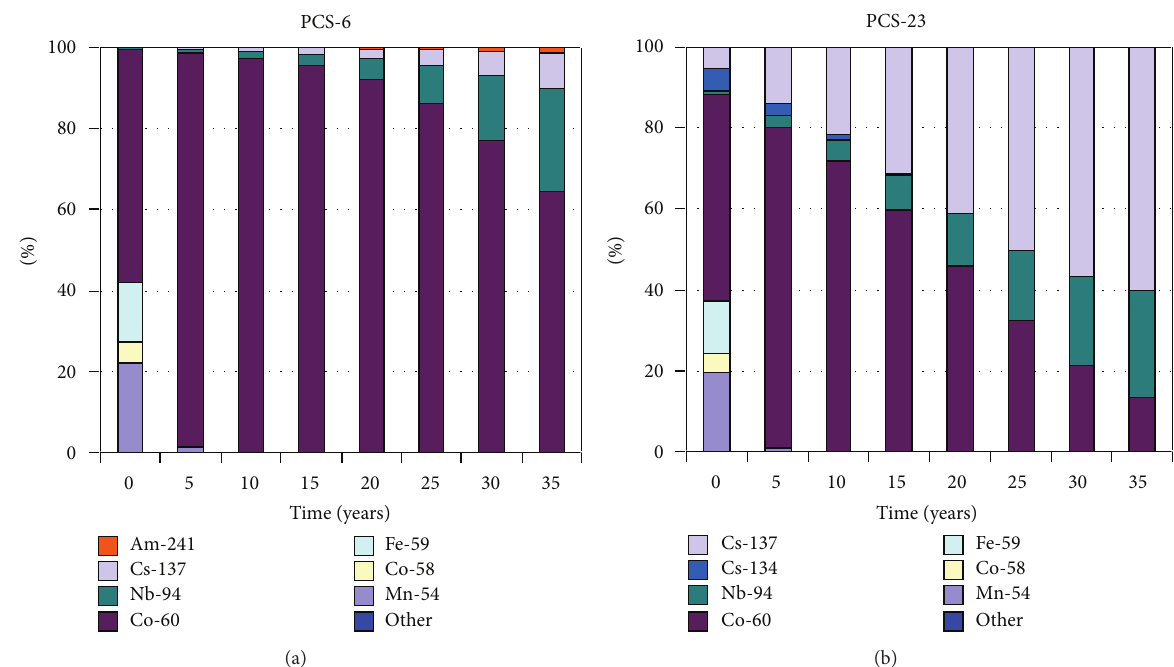
Figure 6: Variation of nuclide composition with time (other < 1%): (a) PCS-6 component and (b) PCS-23